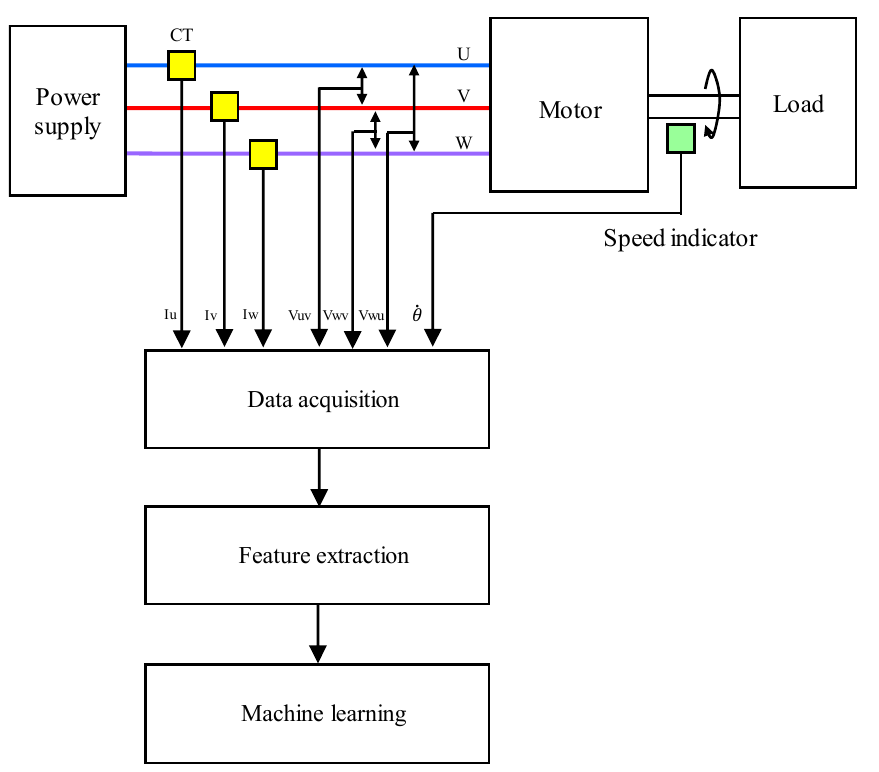
Figure 1. Experimental setup.